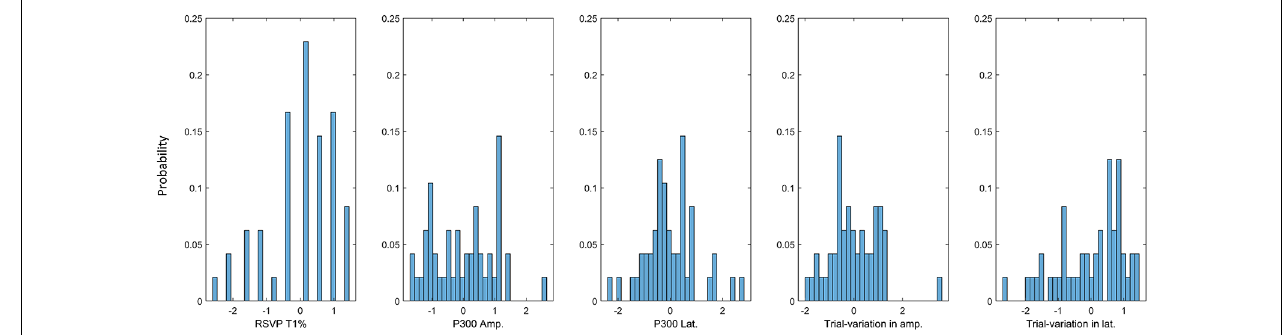
FIGURE 8 | Data distribution of each RSVP feature. The distribution of each of the RSVP features is depicted using relative frequency histograms ( N = 48). Compared to the other RSVP features, RSVP T1% showed a sharp and sparse